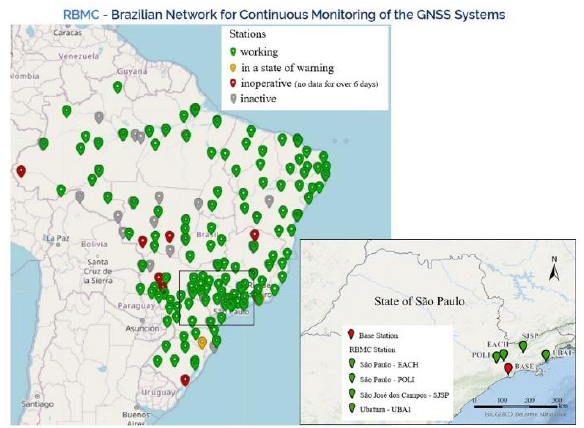
Figure 3 – Structure of the Brazilian GNSS Network (RBMC) used for GNSS base coordinates calculated for the relative post- processing of image and checkpoint